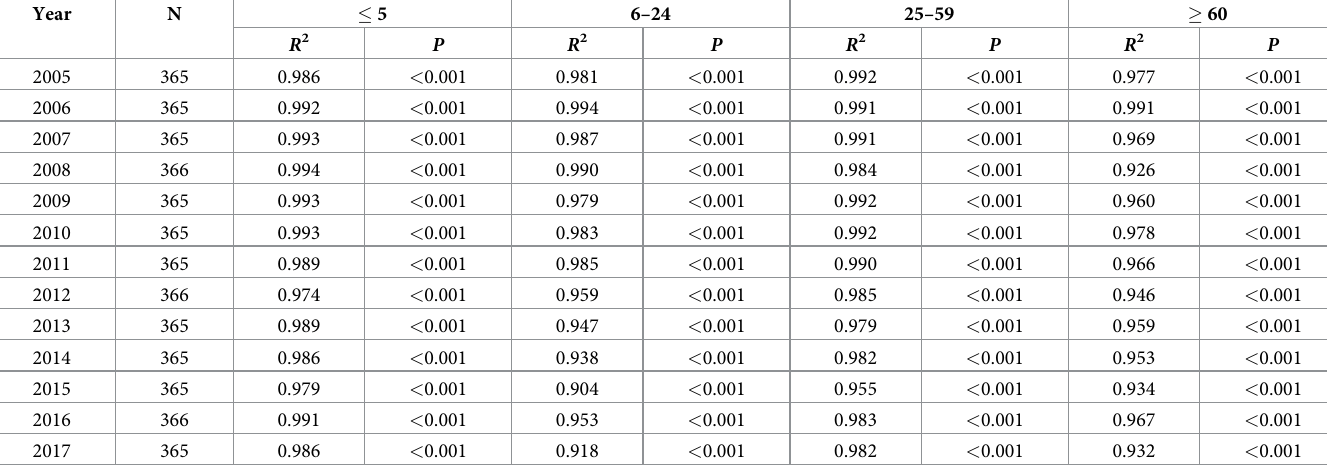
The age-specific SEIAR model fitted the reported data well in all of age groups (Fig 5). The R 2 of the model by age group and year is shown in Table 3. The model simulated for shigellosis in 2007, 2010, 2013 and 2016 (see S1 Table) fitted the data well. The transmissibility of shigellosis among different age groups The highest transmission interaction was between the � 5 years and 25–59 years. The trans- missibility in the � 5 years was mainly within the group (mean R : 0.46, 95% CI: 0.36–0.56) eff (Fig 6A) and the 25–59 years (mean R : 0.49, 95% CI: 0.37–0.61) (Fig 6C). The transmission eff to the 25–59 years was mainly from the � 5 years (mean R : 0.76, 95% CI: 0.34–1.17) (Fig 6I). eff Furthermore, the highest infectivity (Fig 7A) was in the � 5 years ( R = 1.71), which was I most commonly transmitted to the 25–59 years (45.11%) (Fig 7B). The 25–59 years highest susceptibility ( R = 2.51) (Fig 7F), and the most common source of transmission in this age S group was from the � 5 years (30.15%) (Fig 7I). Table 3. R 2 of model and reported cases in different age groups from 2005 to 2017 in Hubei Province, China.